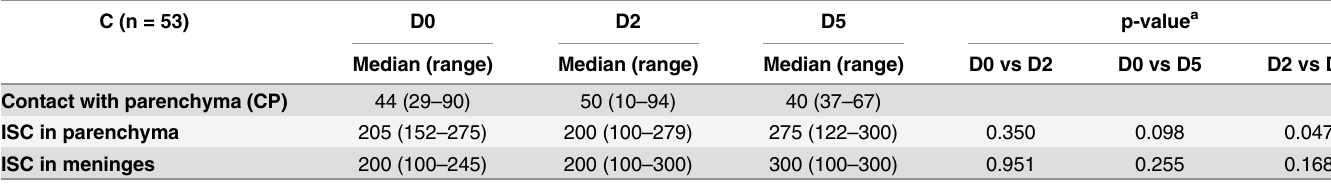
Contact with parenchyma